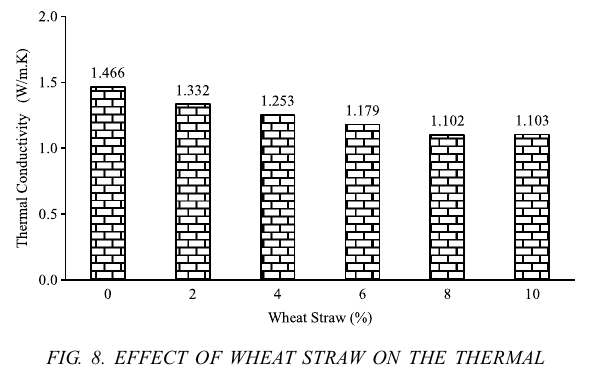
FIG. 8. EFFECT OF WHEAT STRAW ON THE THERMAL CONDUCTIVITY